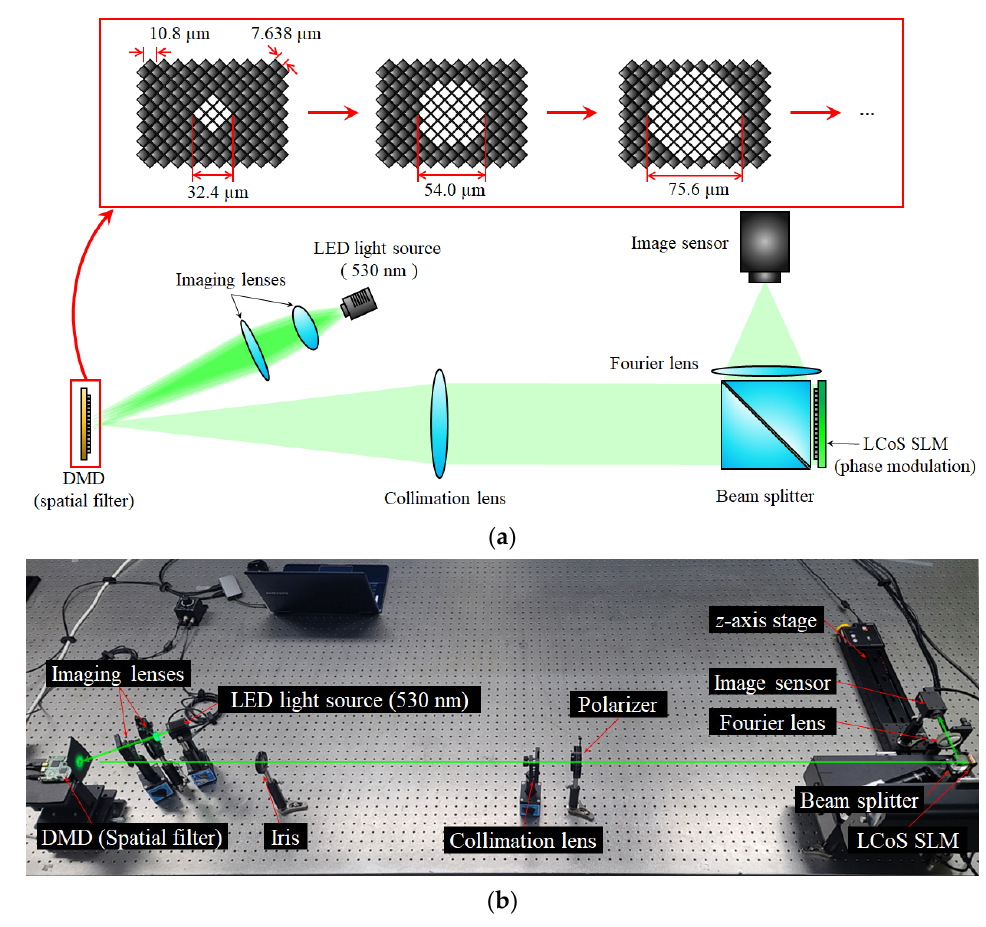
Figure 2. Holographic display system with controllable spatial coherence using a digital micro-mirror device (DMD). ( a ) The scheme of the proposed system and ( b ) the experimental setup.